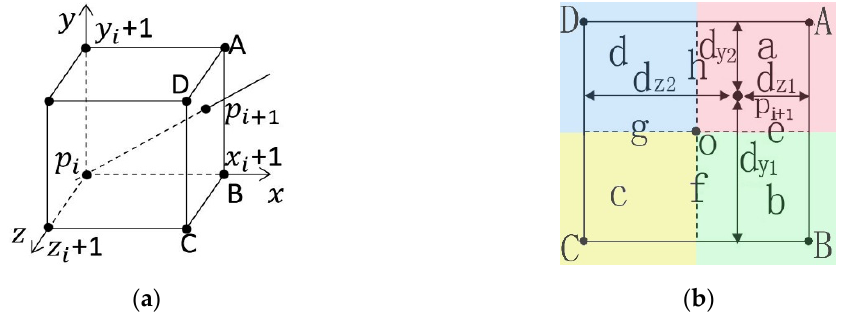
Figure 4. Method of discriminate regions. ( a ) A straight line in a unit grid. ( b ) The position of the desire point in the plane.